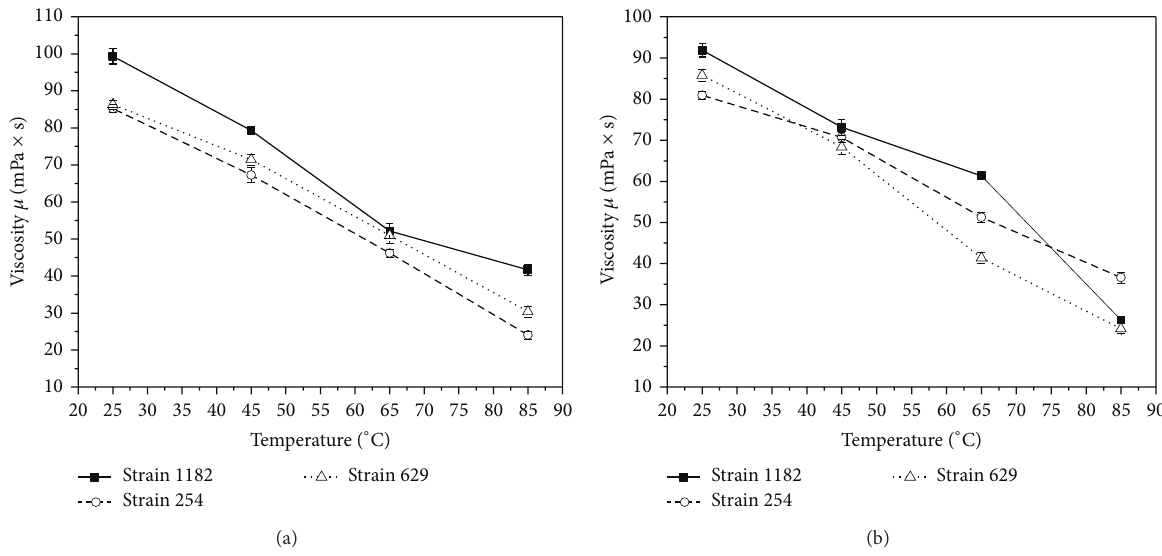
Figure 4: Apparent viscosities of the xanthan gums (0.5% w/v) obtained from SSAE (a) and from sucrose (b) at different temperatures (25 to 85 ∘ C). Shear rate is 𝛾 25s −1 .